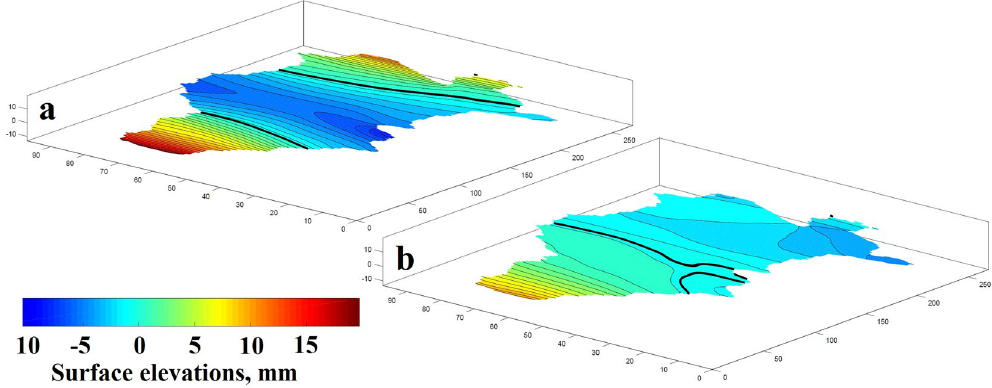
Figure 6. Level surfaces of seiche modes with the periods of ( a ) T = 5.2 h and ( b ) T = 2.7 h modelled for the west site.